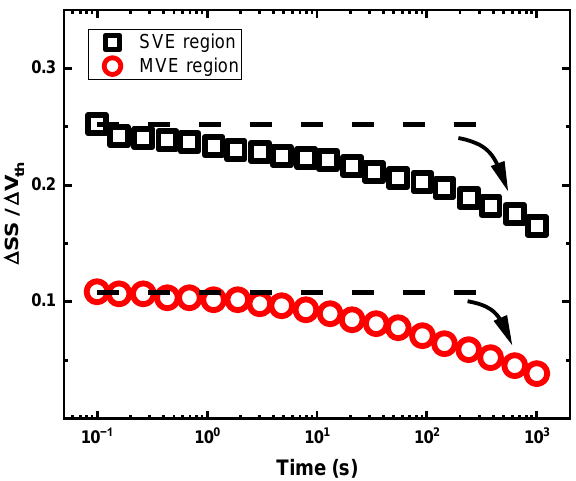
Figure 7. ∆ SS ( i ) / ∆ V th ( i ) drops with time in FinFET Figure 7. V   drops with time in FinFET [29].